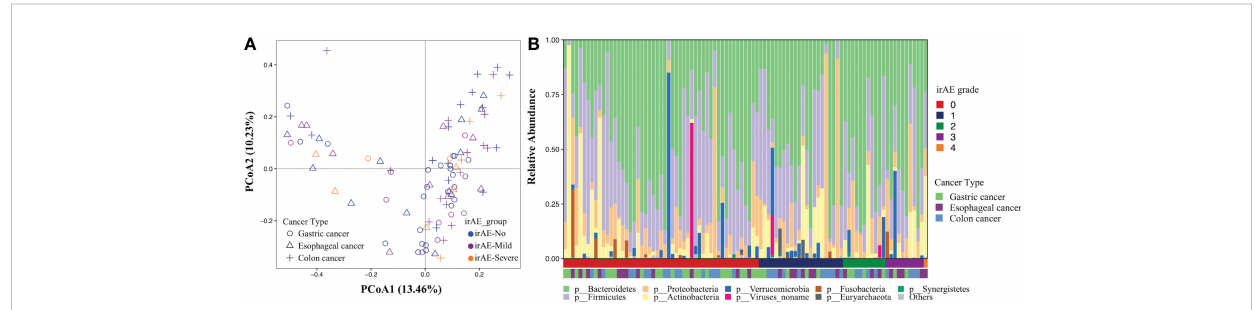
FIGURE 2 Gut microbial composition associated with immune-related adverse events. The analysis was performed on all patients. (A) Principal coordinates analysis of the microbial community based on the Bray-Curtis distance calculated at the species level. Each dot represents a stool sample with shape and color indicating cancer types and the severity of irAE. (B) Phylogenetic composition of common bacterial taxa at the phylum level, ordered by the irAE grade (the fi rst horizontal bar underneath) and cancer types (the second horizontal bar underneath).